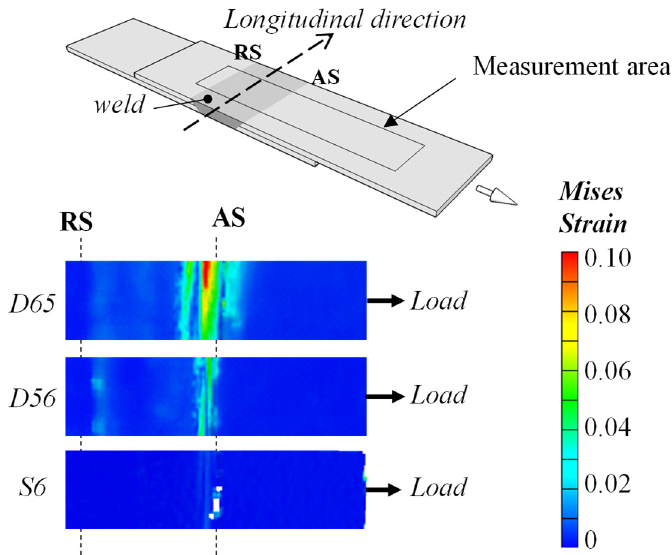
Figure 6. Von Mises strain maps at the maximum load for the welds produced with the CN8